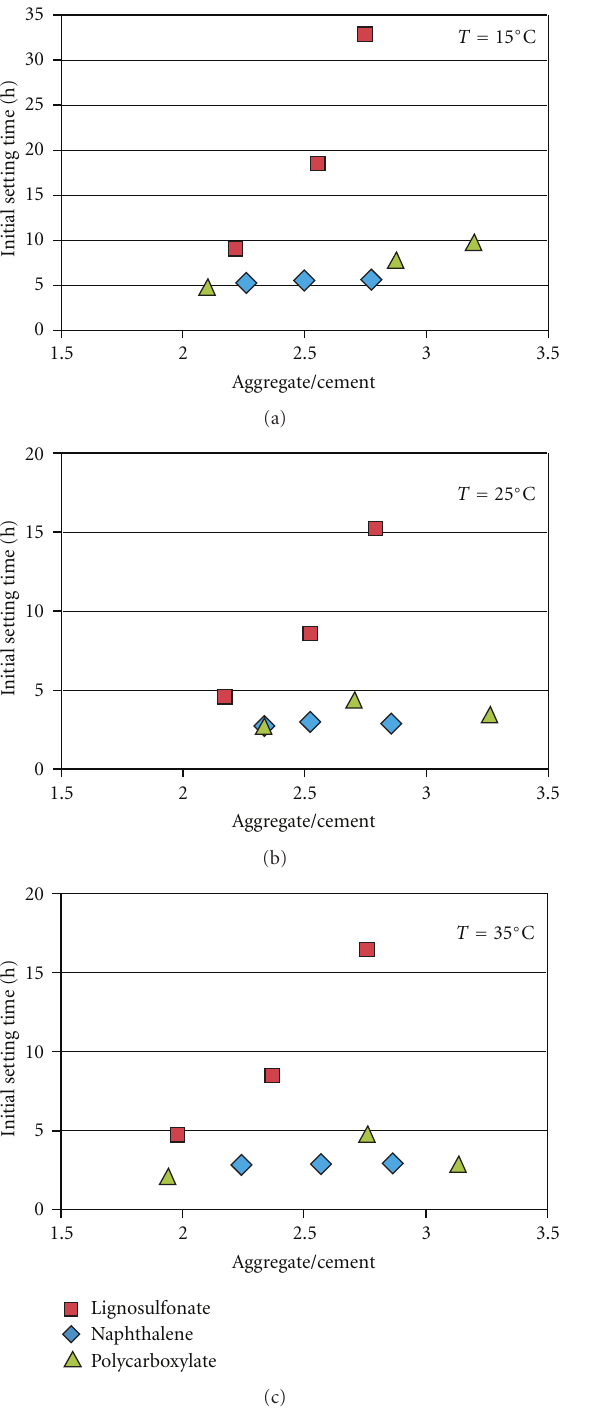
Figure 11: E ff ect of aggregate/cement content and temperature variation on initial setting time of mortar produces di ff erent admixtures dosages.